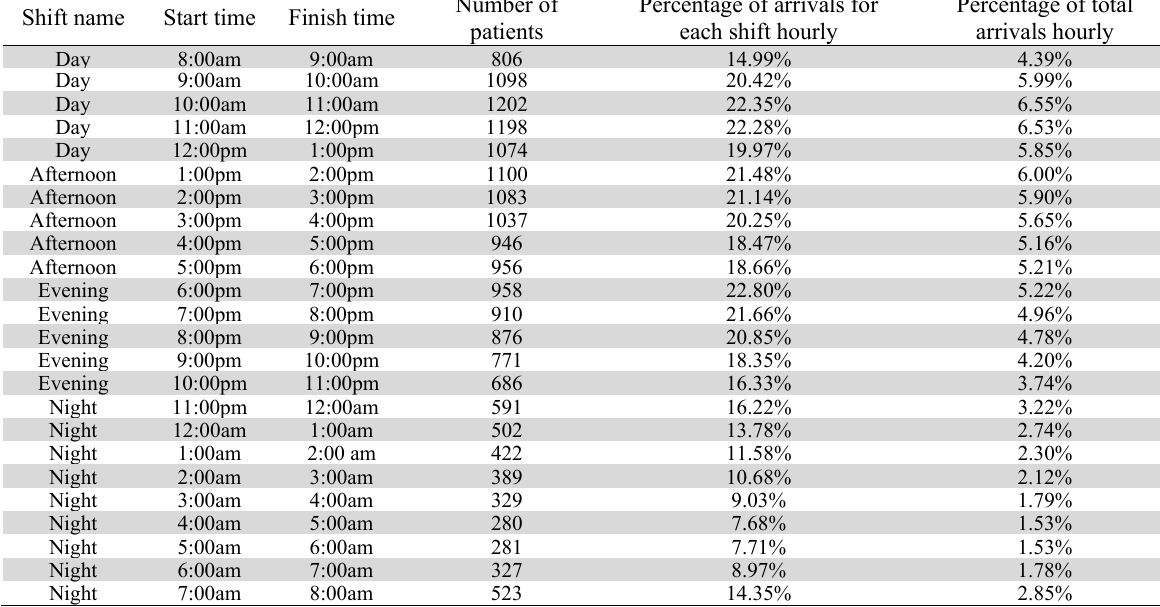
Percentage of patients’ arrival for three